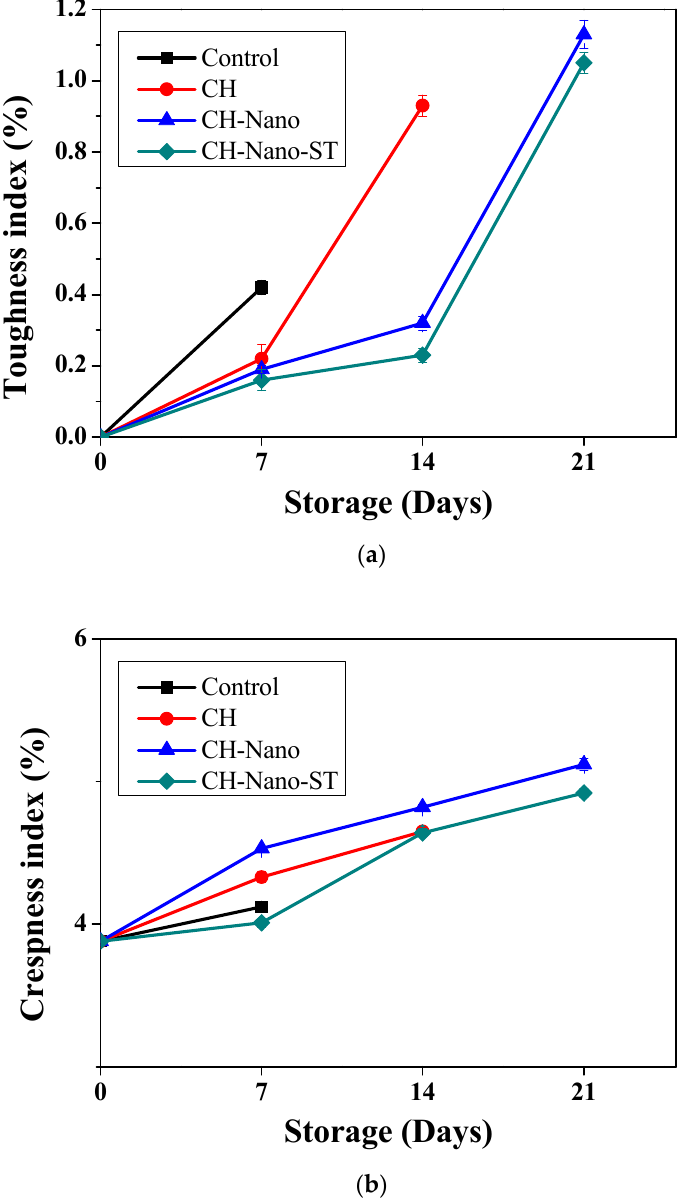
Figure 4. Effect of coating treatments of cucumber sampleson texture properties; toughness indexes ( a ), and crispness index ( b ).